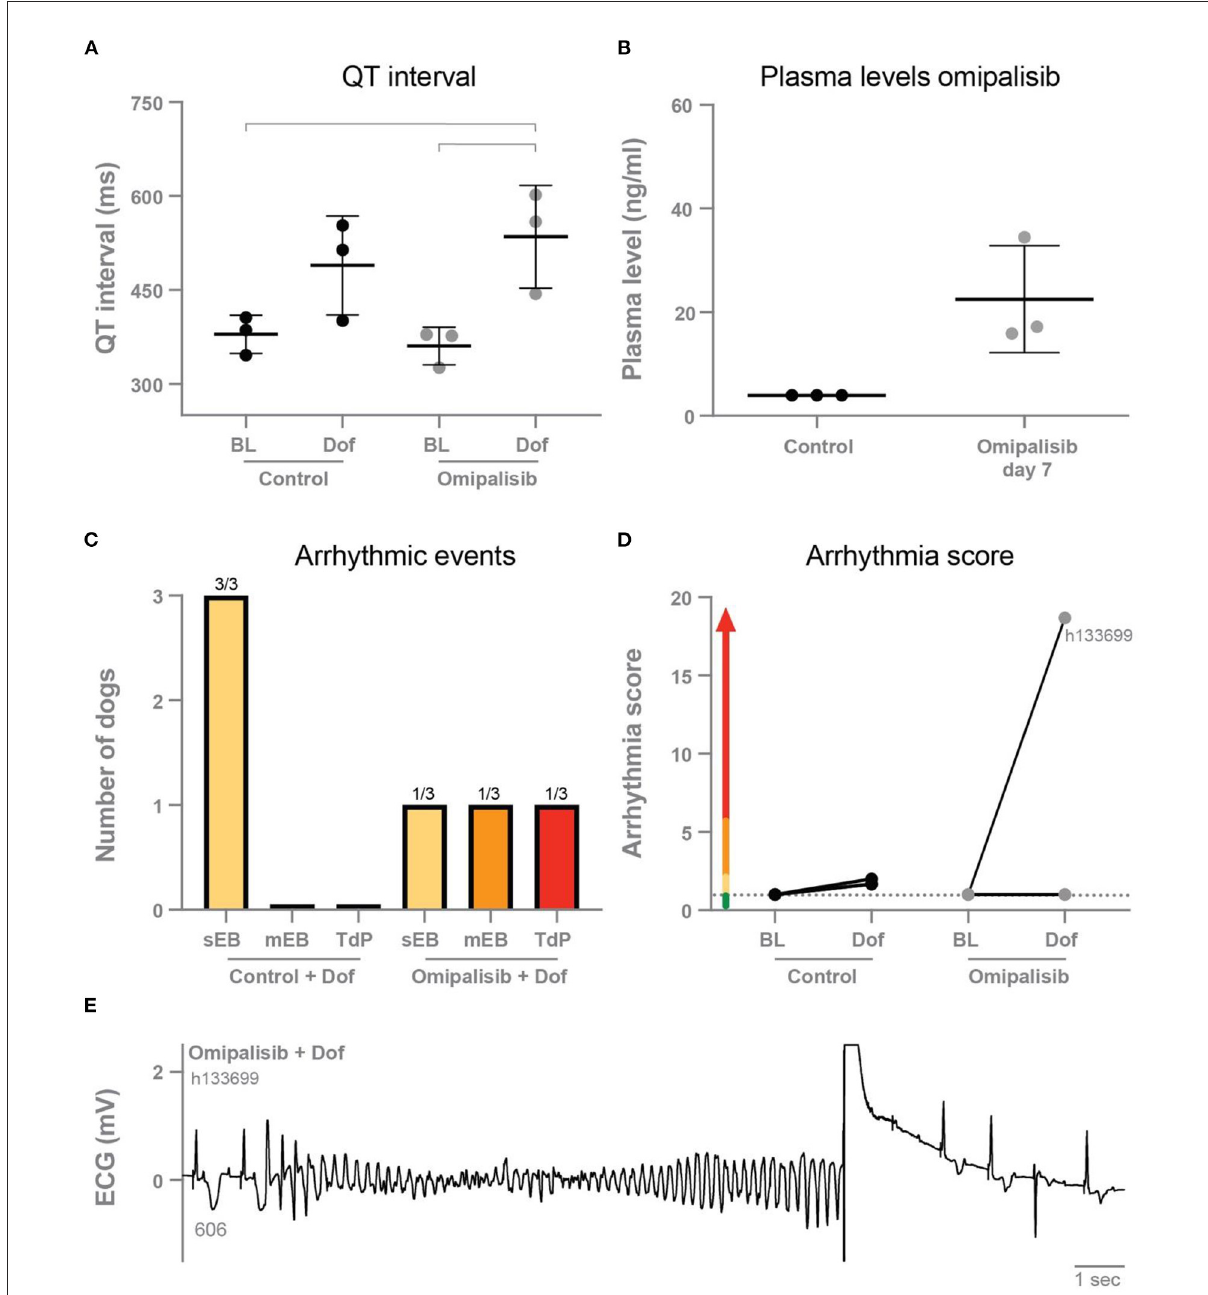
FIGURE2 (A) QT interval during baseline and dofetilide before treatment (control) and after omipalisib treatment (1 mg/kg once a day). Repeated measures two-way ANOVA with Tukey’s multiple comparisons, bars refer to p < 0.05. (B) Plasma levels of omipalisib before (values < 4ng/ml) and after 7 days of omipalisib treatment. Data are presented as mean SD. (C) Incidence of arrhythmic events. (D) Arrhythmia score of dogs ± before (control) and after 1 mg/kg omipalisib once a day. Single ectopic beats (sEB, scored with 2 points), multiple ectopic beats (mEB, scored with 3–5 points), and Torsade de Pointes (TdP) arrhythmia (scored with 6–49 points). TdP arrhythmia demanding defibrillation was scored with 50, 75 or 100 points depending on the number of shocks. (E) ECG lead II showing a defibrillated TdP arrhythmia after omipalisib treatment and dofetilide infusion in dog h133699. The QT interval (ms) of the complex before the TdP is stated below the T